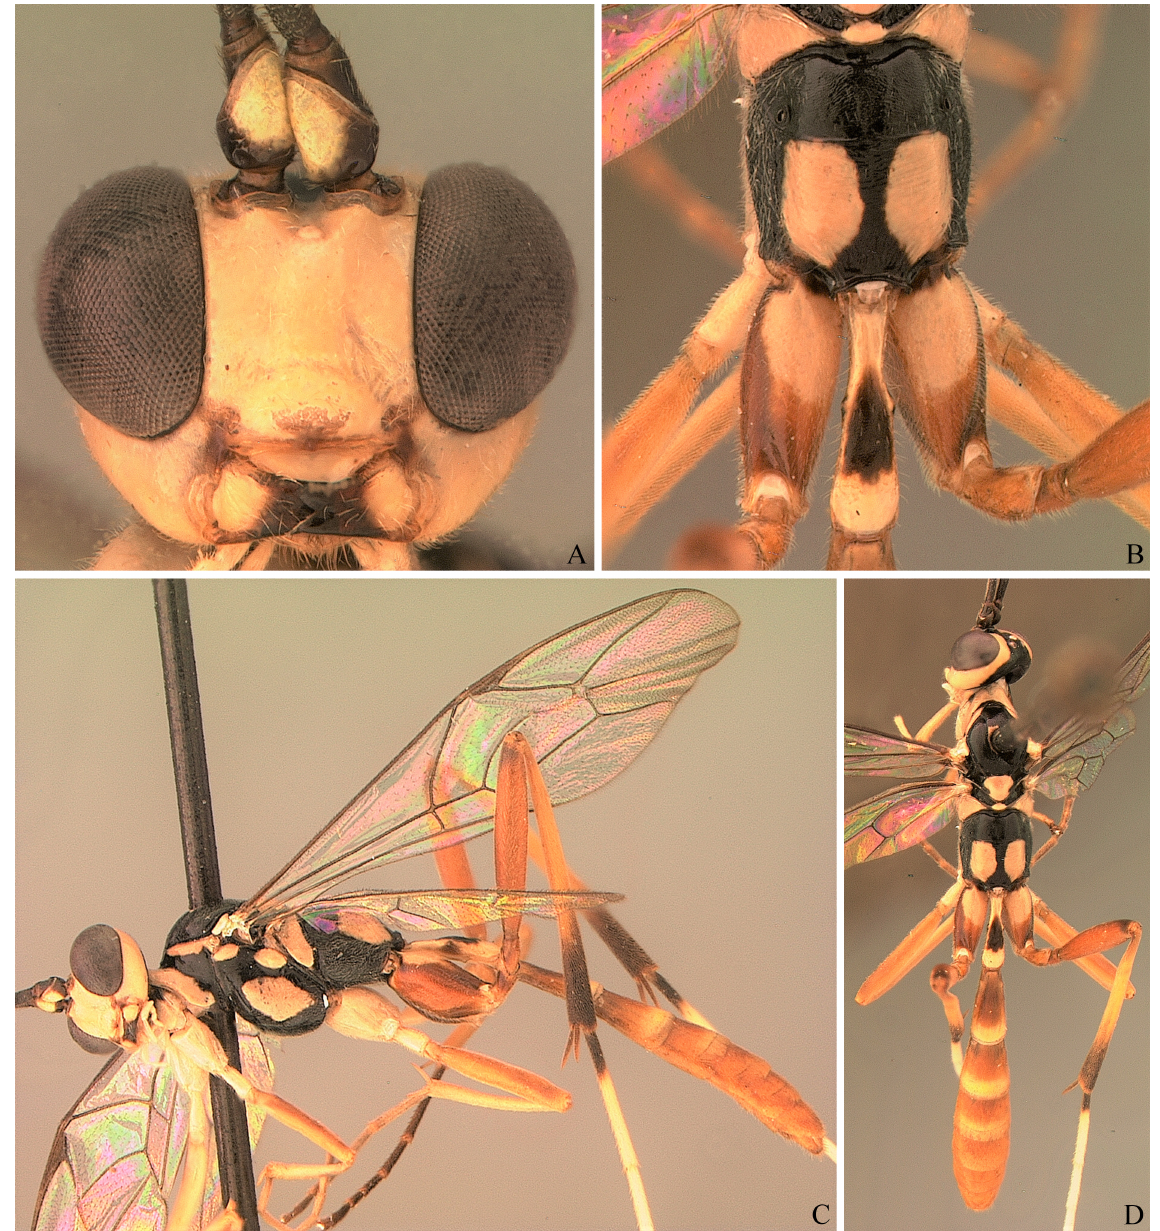
light yellow, median 0.5 blackish; T2–4 with posterior yellow stripes. Unknown.